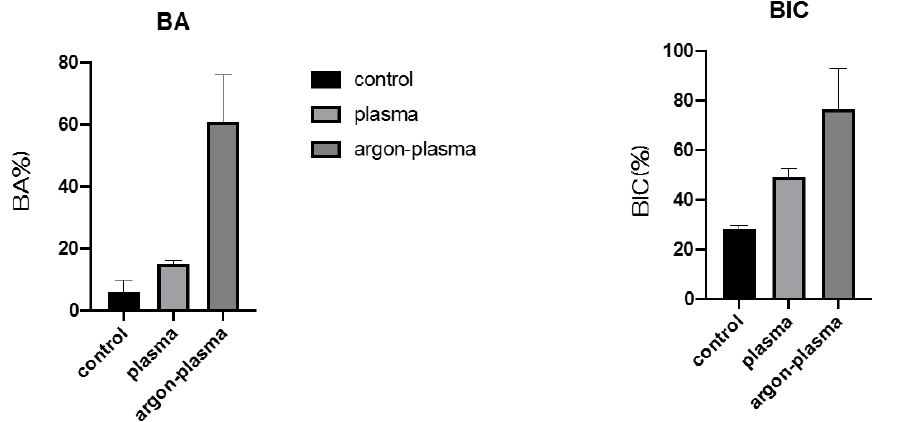
Figure 12. Quantitatively, histomorphometric analysis showed that the bone area ratio (BA) and bone-to-implant contact (BIC) on the material surface were significantly the highest for the argon plasma-treated group, among all three groups.